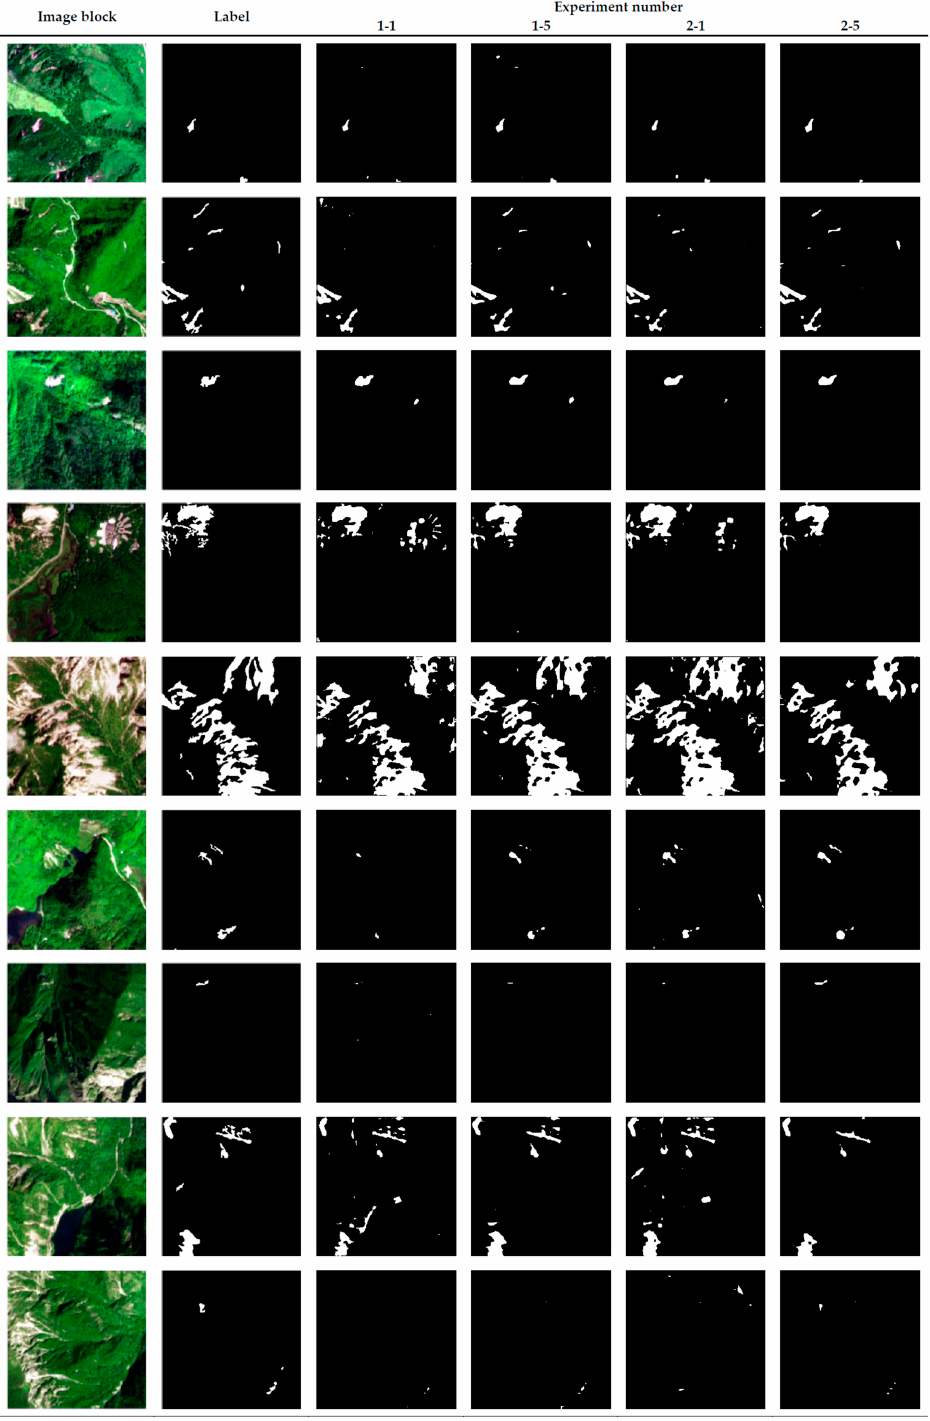
Figure 11. Comparison of prediction results of four main model